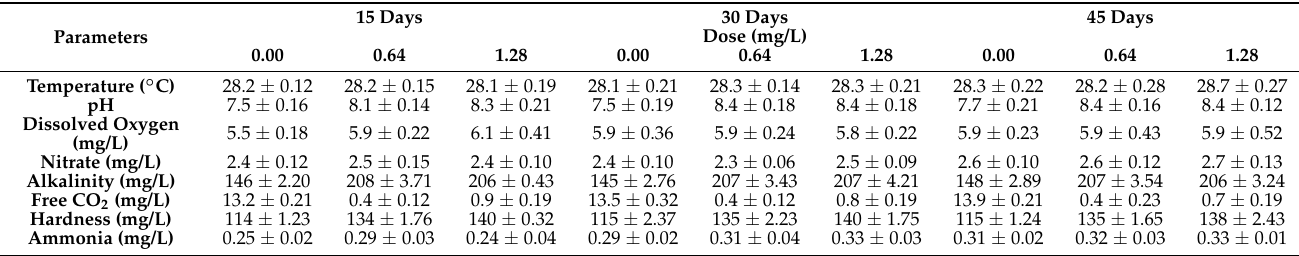
Table 1. Physico-chemical parameters of the control and test medium (0.64, 1.28 mg diazinon/L) used during the chronic toxicity